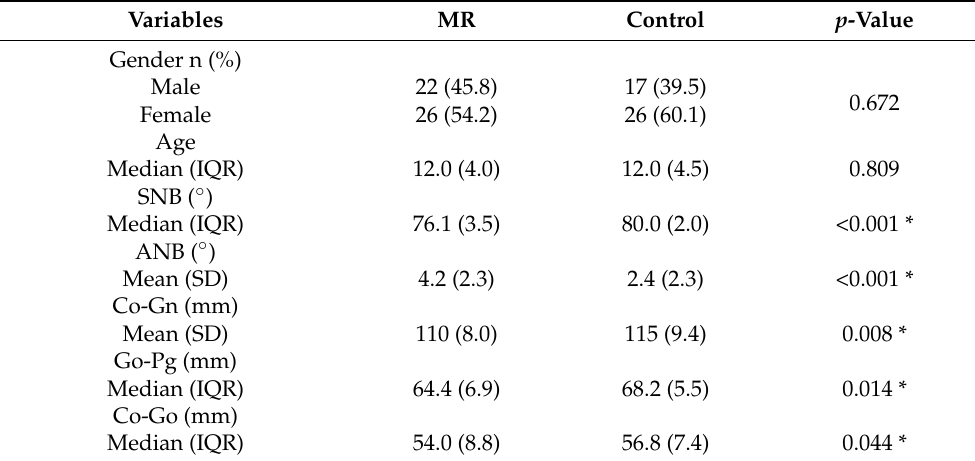
Table 2. Comparison of cephalometric variables between mandibular retrognathism and con- trol groups.